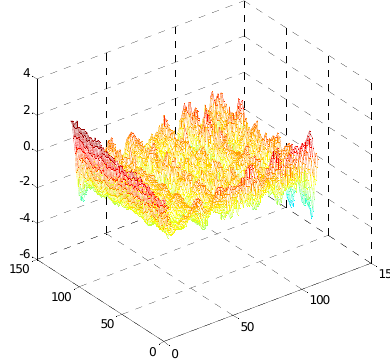
Figure 3 . Surface difference between reference and reconstructed surface from 2 m samples.